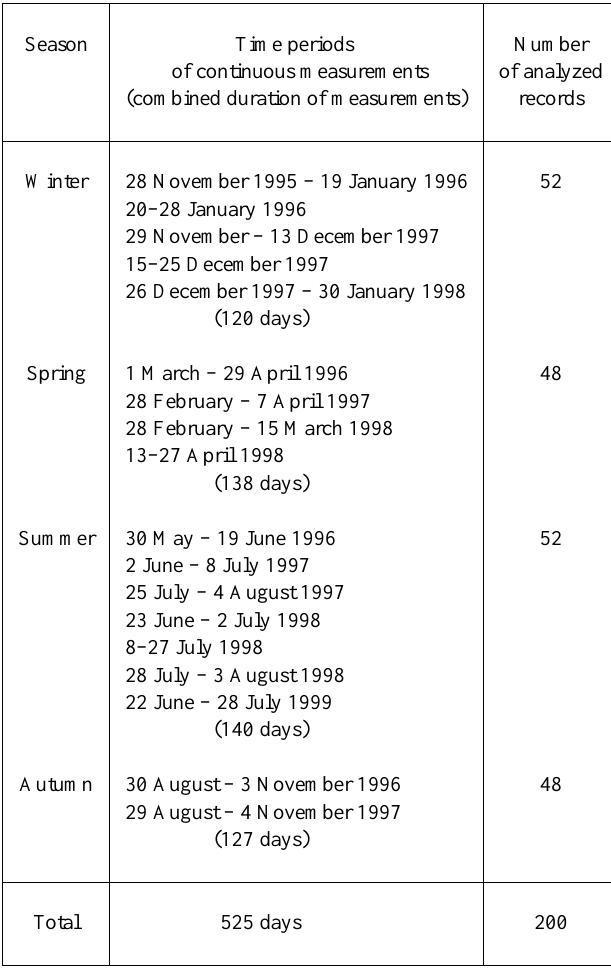
Table 1. Time periods of synchronous co-located microbarograph and seismograph observations at St.Petersburg (60 ◦ N, 30 ◦ E),